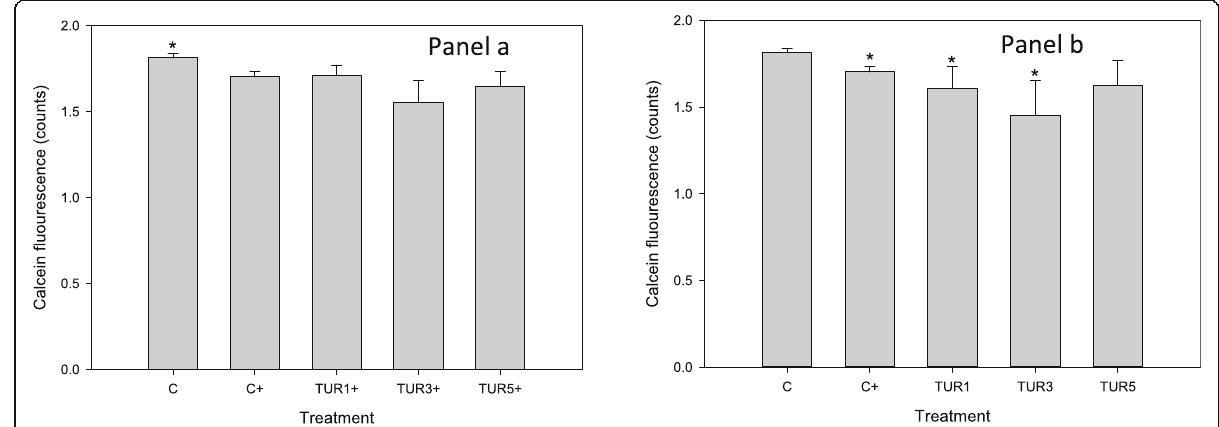
Fig. 4 Calcein staining (as a measure of cell viability) of cartilage explants conditioned with simulated biological extract of turmeric (3, 9 or 15 μ g/ mL; TUR1, TUR3 and TUR5 respectively) compared with simulated biological extract containing no turmeric (C) in the presence (Panel a ) or absence (Panel b ) of lipopolysaccharide (LPS; 5 μ g/mL). Explants were cultured for a total of 96 h and were conditioned with TUR for the first 48 h prior to exposure to LPS. * denotes significant change from